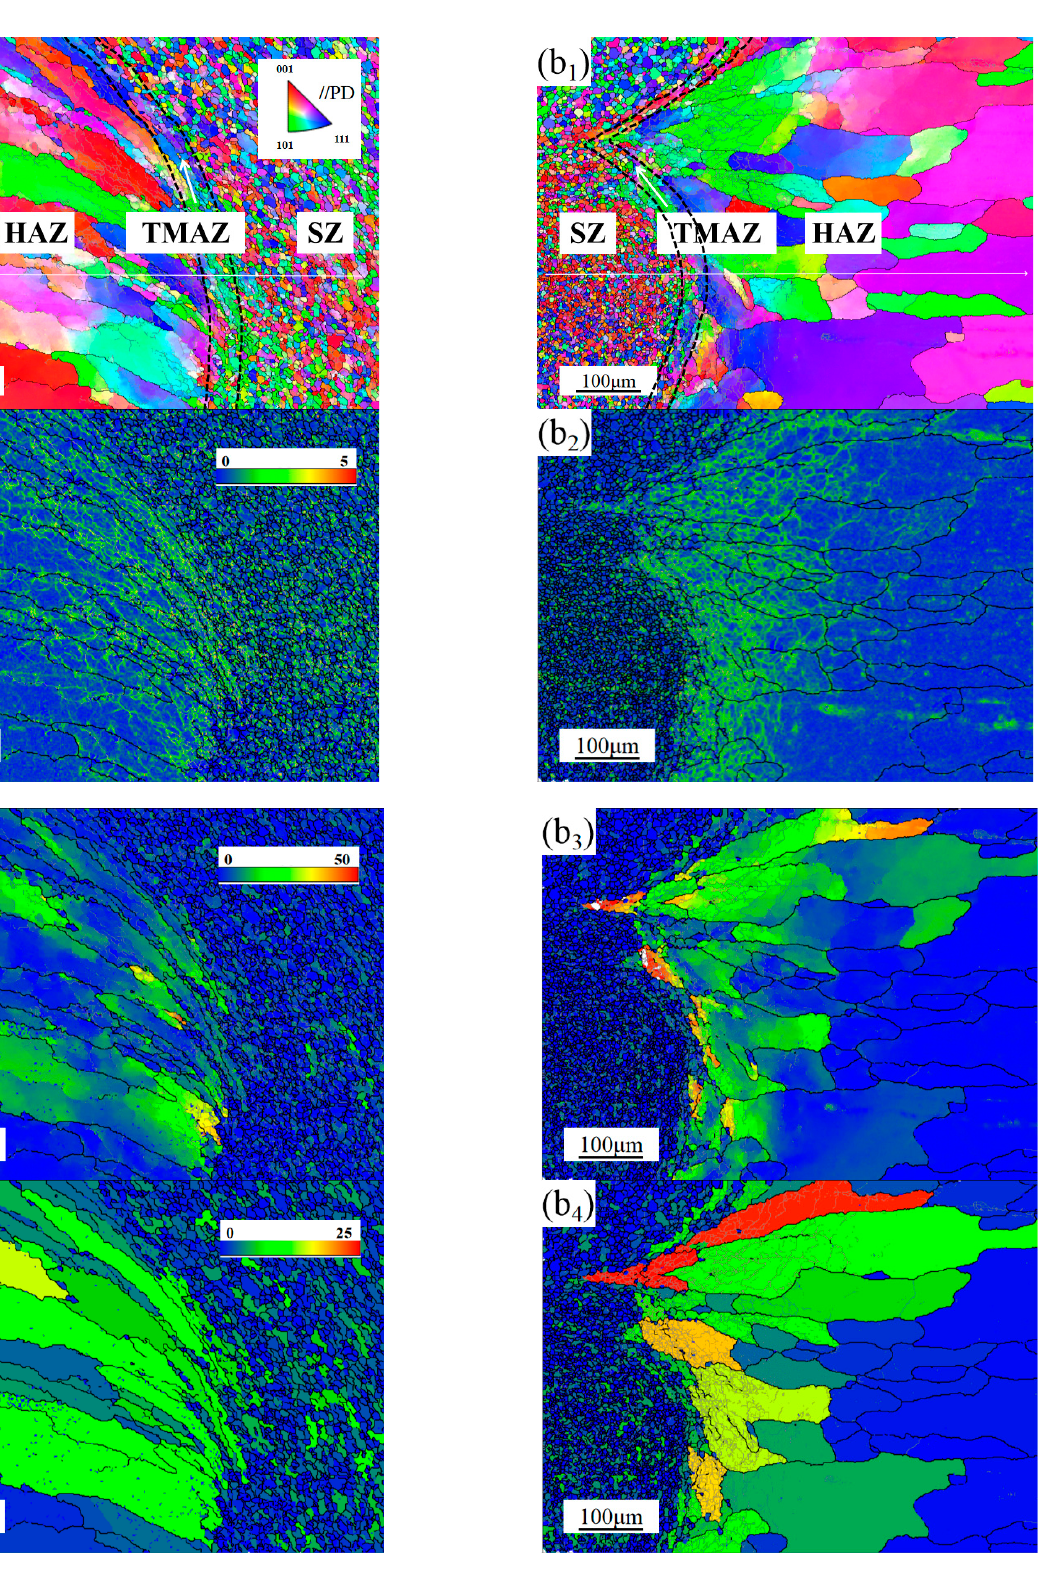
Figure 11. IPF, KAM, GROD angle and GOS maps of ( a 1 – a 4 ) AS and ( b 1 – b 4 ) RS.